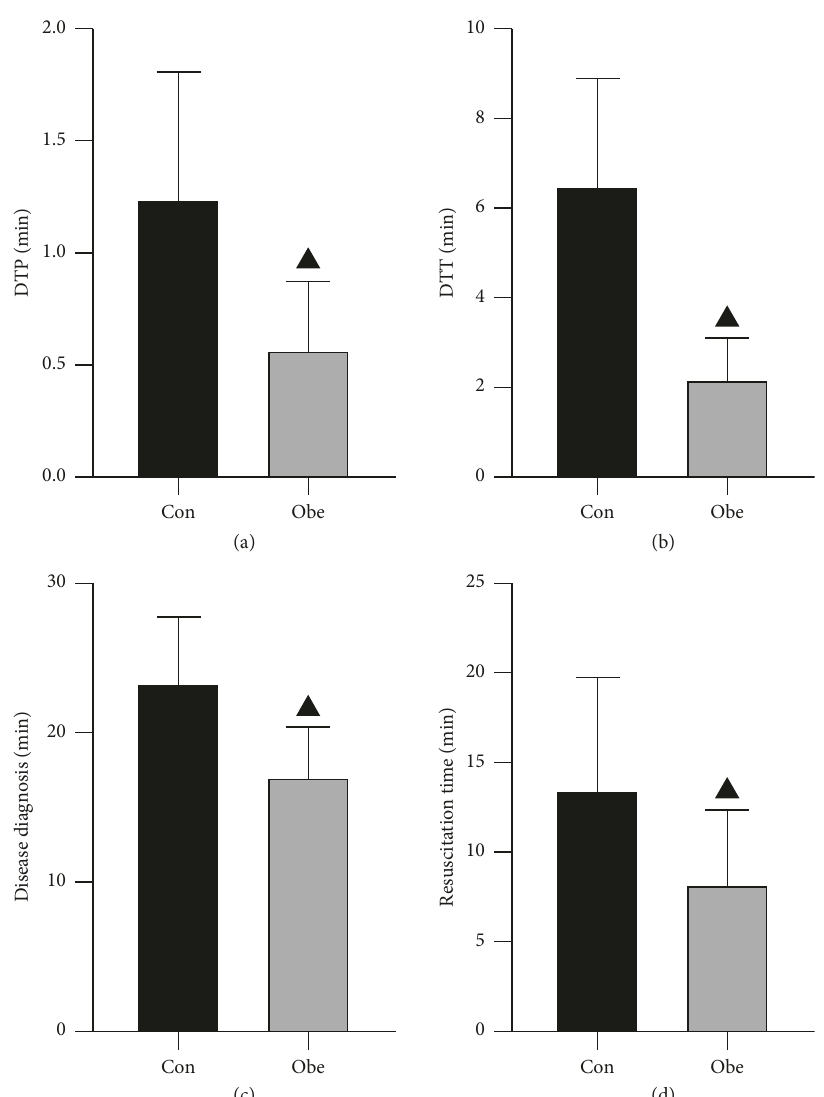
Figure 1: Comparison of the effect of first aid between the two groups. Note. ▲ indicates P < 0 . 05 compared with the control